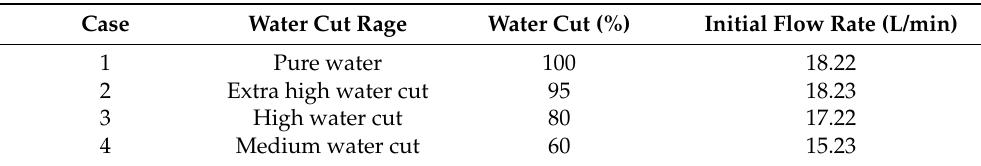
Table 1. Experimental conditions at different water